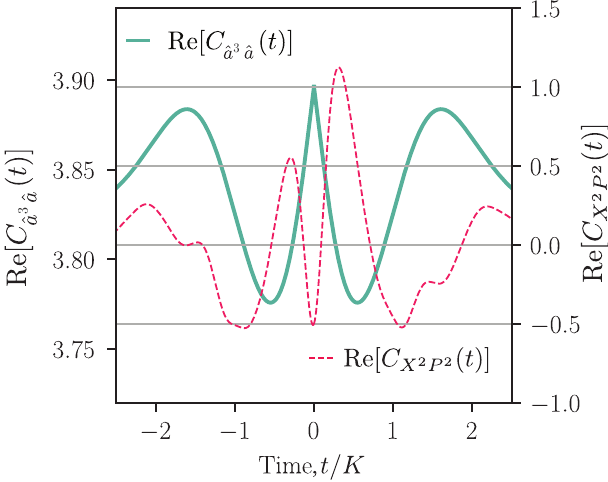
FIG. 6. Time symmetry of special correlation functions in a driven Kerr resonator. Real part of the connected, steady-state ( t ) ≡ (cid:5)ˆ a 3 ( t ) ˆ a (cid:6) [cf. Eq. (63)] for a para- correlation function C a 3 , a metrically driven nonlinear cavity with (cid:15) 2 = K , κ 1 = 0.4 K , and = (cid:15) = (cid:9) = 0. This correlation function is symmetric in t , κ 2 1 something that is guaranteed by the existence of hidden TRS. We ( t ) (where ˆ X , also plot another quartic correlation function C X 2 P 2 ˆ P are canonical quadrature operators). This correlator is clearly asymmetric as a function of time. hidden TRS ensures only that a certain restricted class of correlators are time symmetric (in con- trast to the more commonly studied CQDB, which guarantees all correlators exhibit a form of time